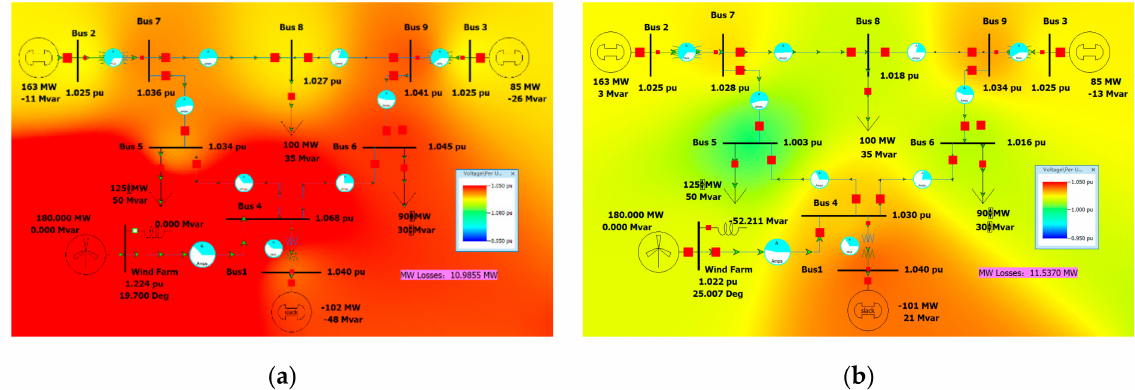
Figure 13. Simulation results of the minimum load of tower C connected to bus 8 (500 km). ( a ) Minimum load condition. ( b ) Minimum load condition with reactor.